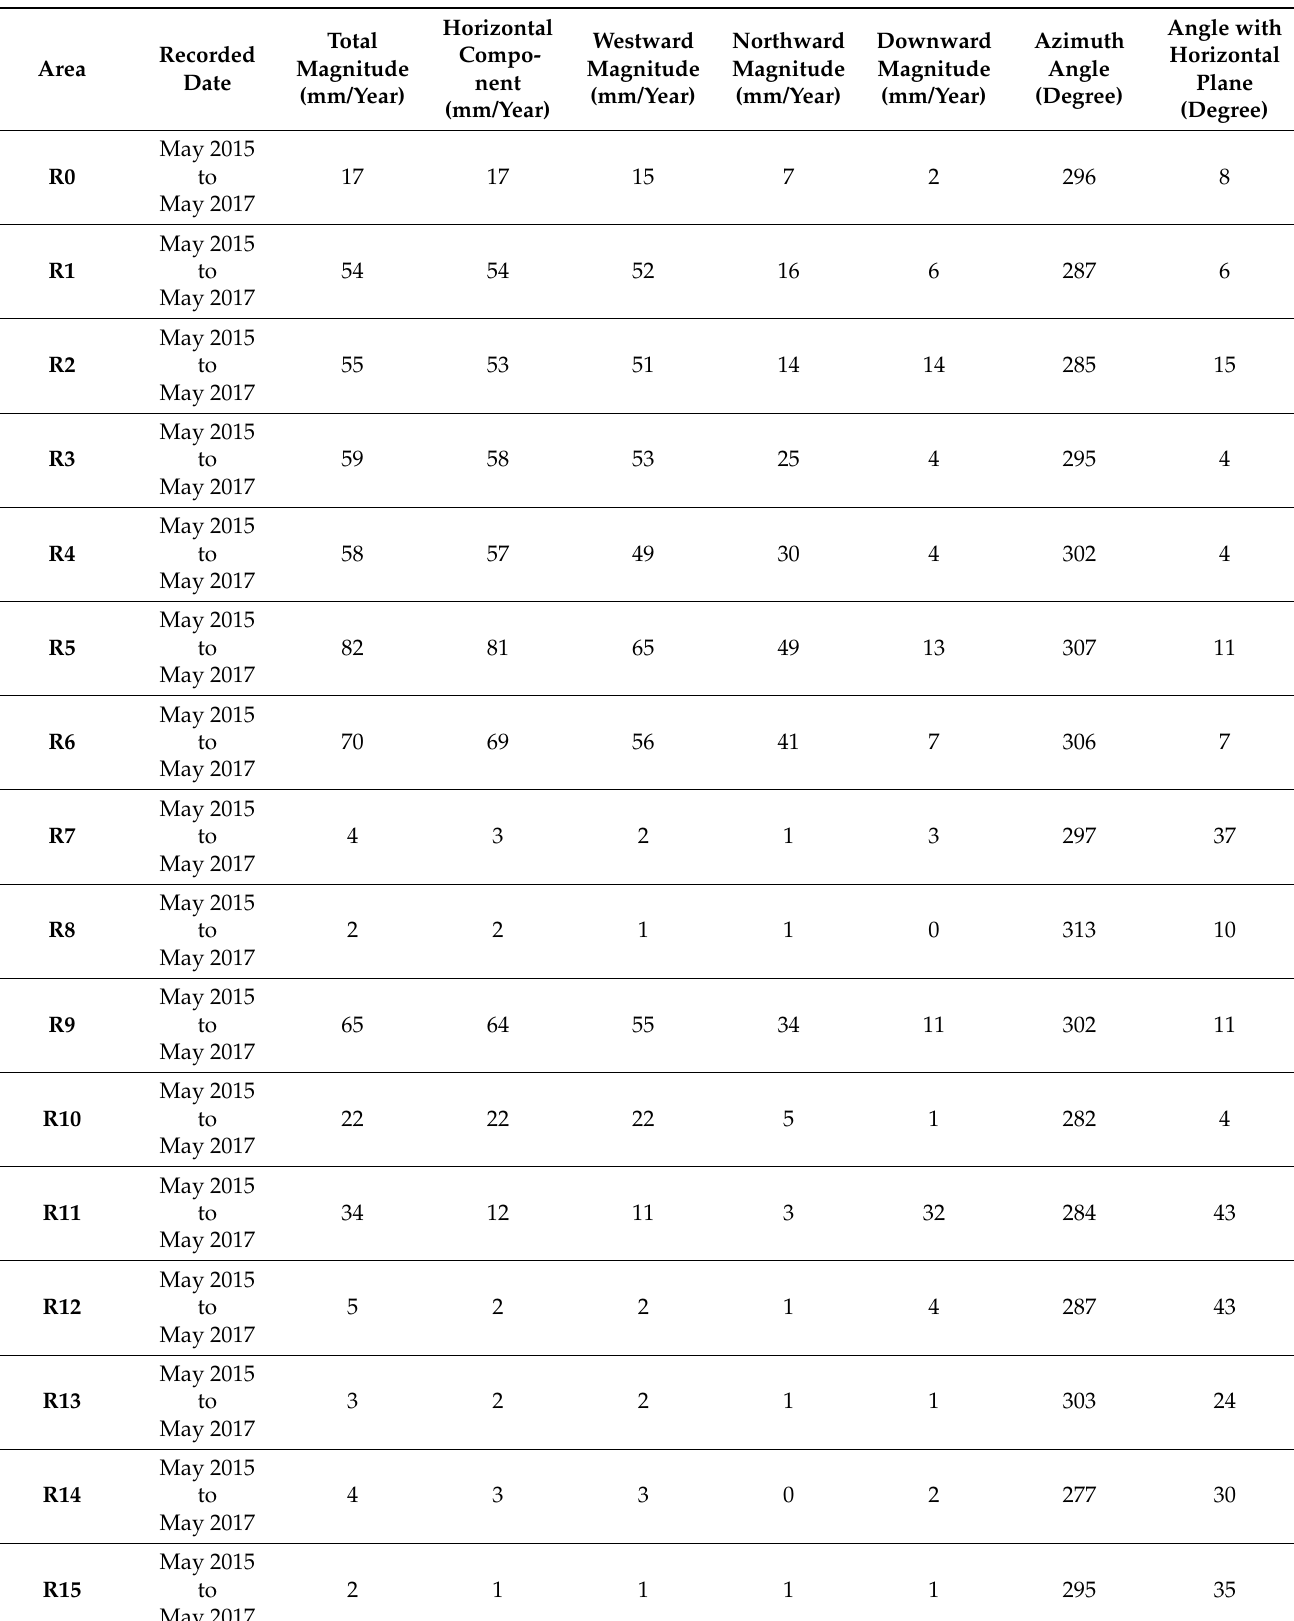
Table 3. Magnitudes of R and